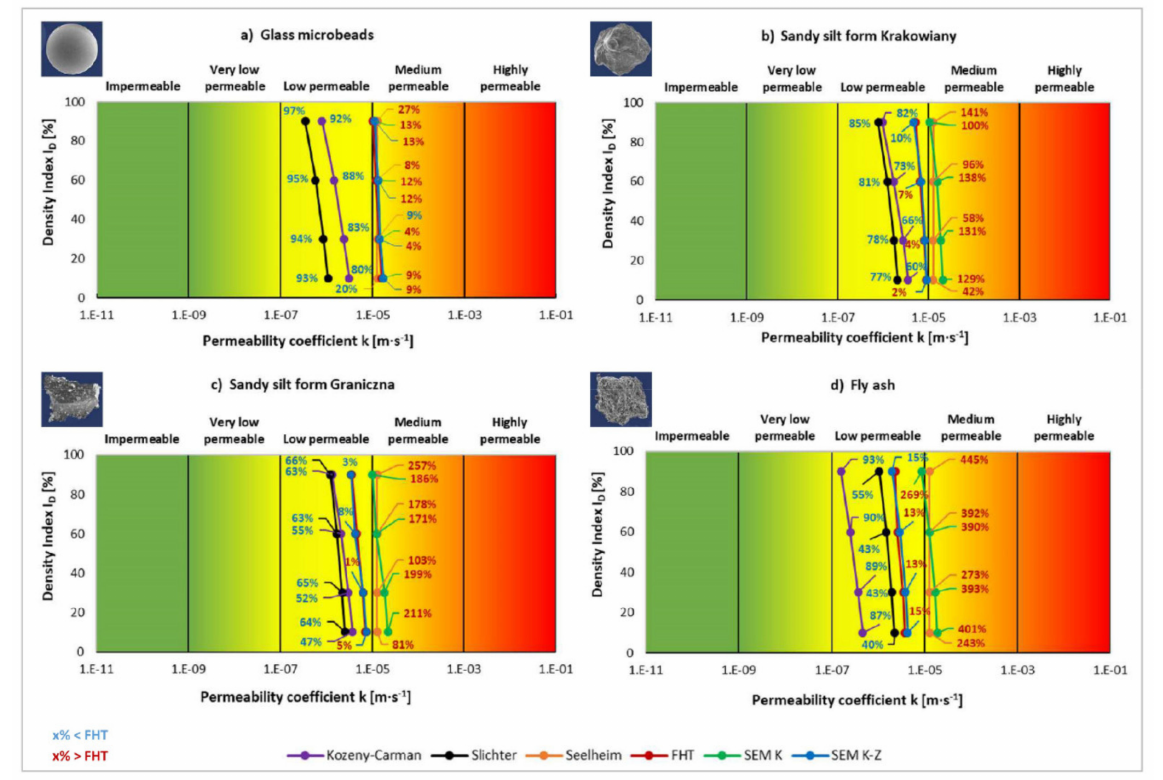
Figure 10. Purpose-made classification of engineering-geological environment permeability (suitable—green, conditionally suitable—yellow, unsuitable—red) based on permeability coefficient, where low permeability is perceived as a positive property of rock